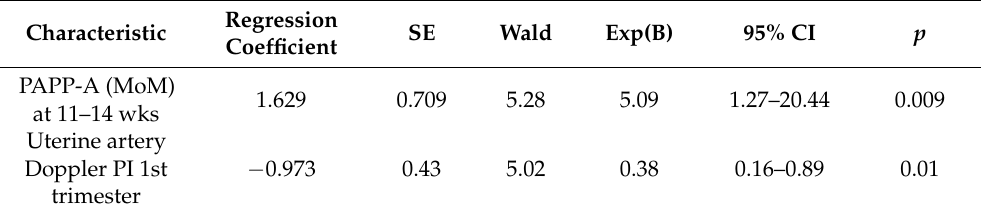
Table 3. Logistic regression analyses with the dependent variable fetal growth restriction (fetal birth weight percentile <